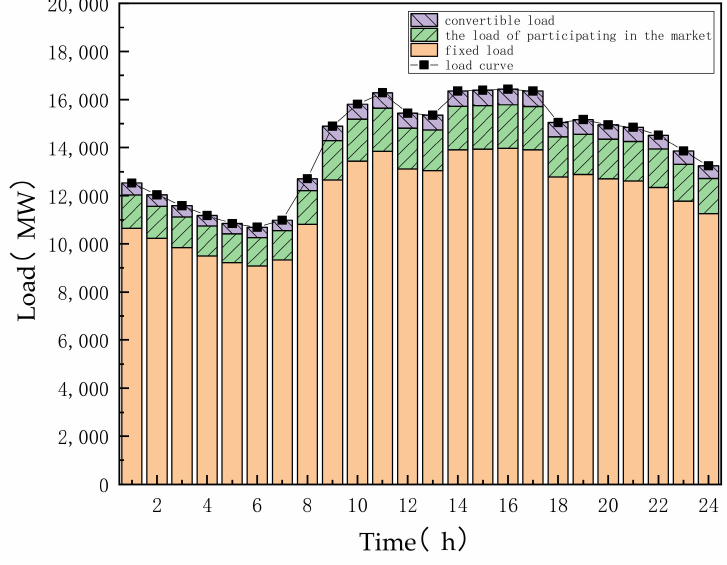
Figure 8. Load curve and proportion of the flexible